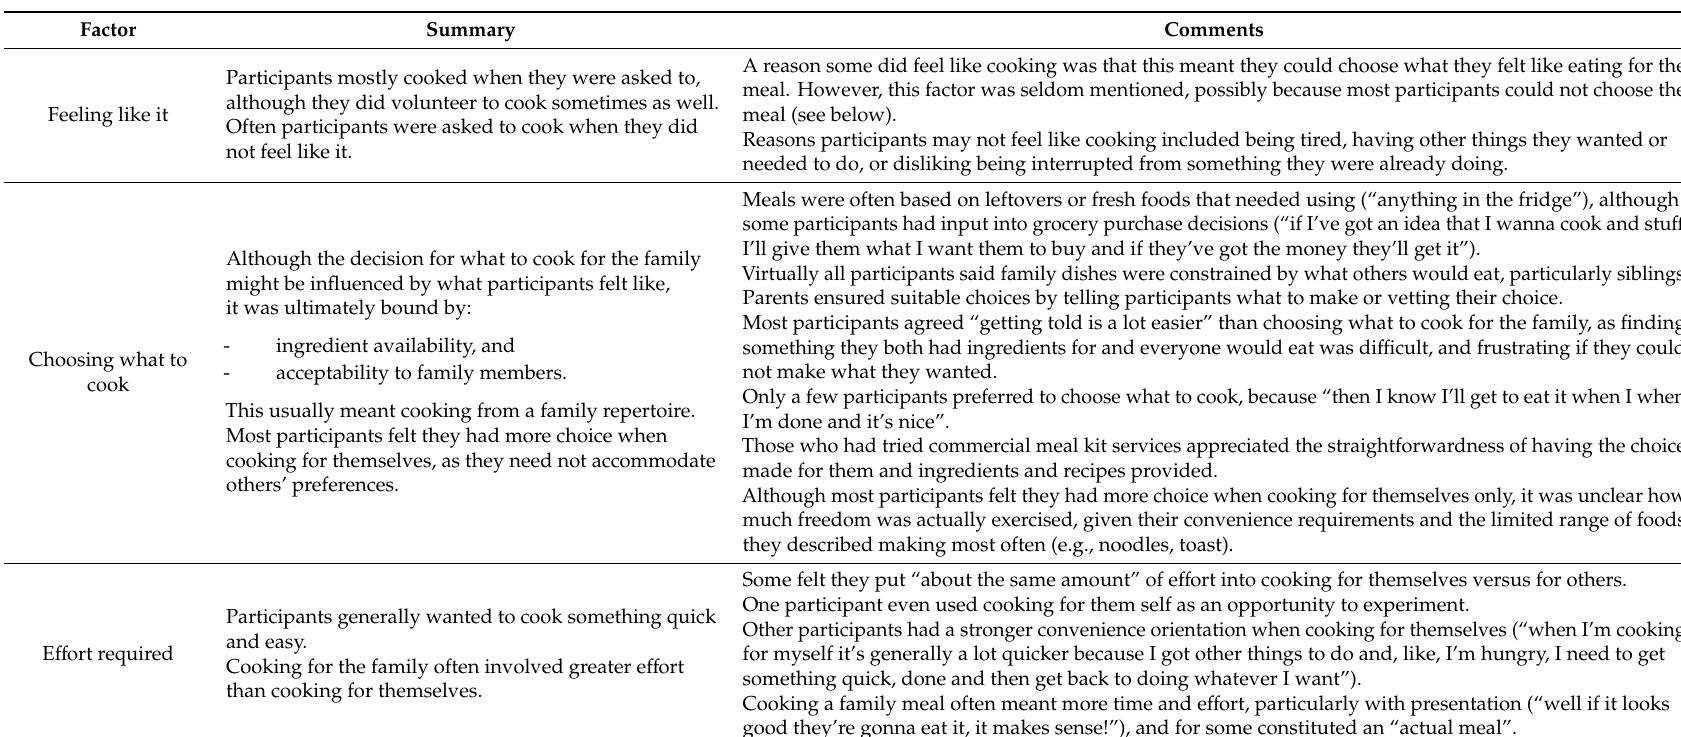
Table 4. Factors influencing participants’ experiences of cooking at home during end-of-study